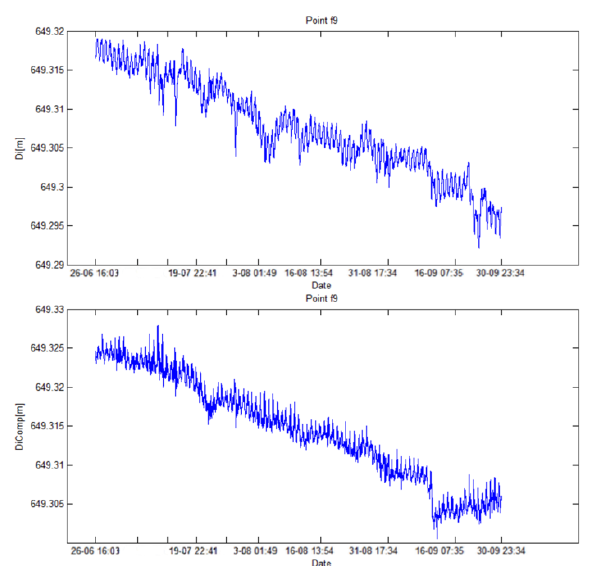
Figure 16. Raw and corrected values of distance for point f9